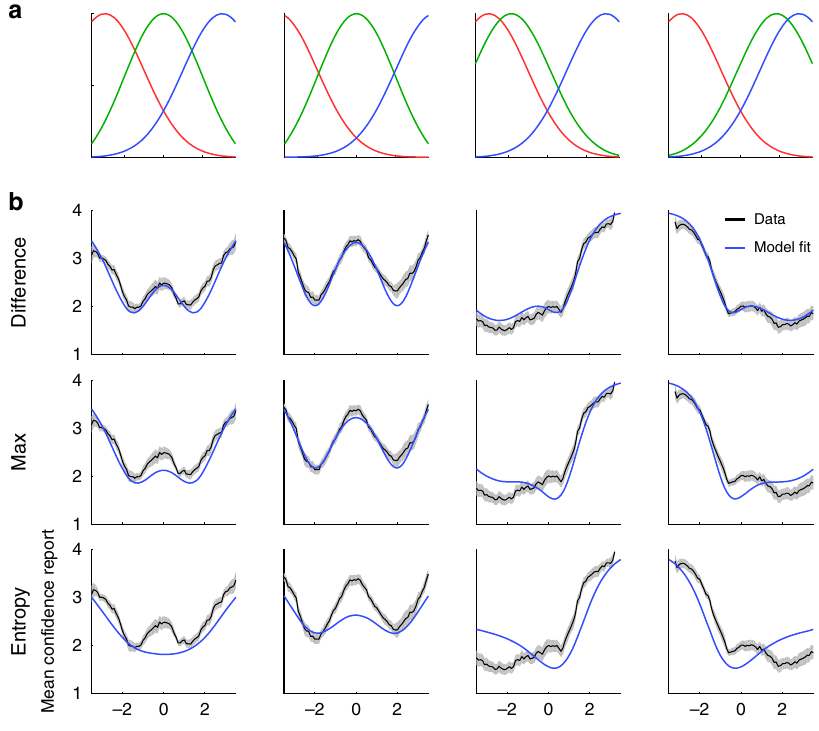
Fig. 3 Experiment 1. a The distribution of the reference dots in each condition. b Mean con fi dence report as a function of target position for each of the four conditions. The black curves represent group mean ± 1s.e.m. Blue curves represent the model fi t averaged across